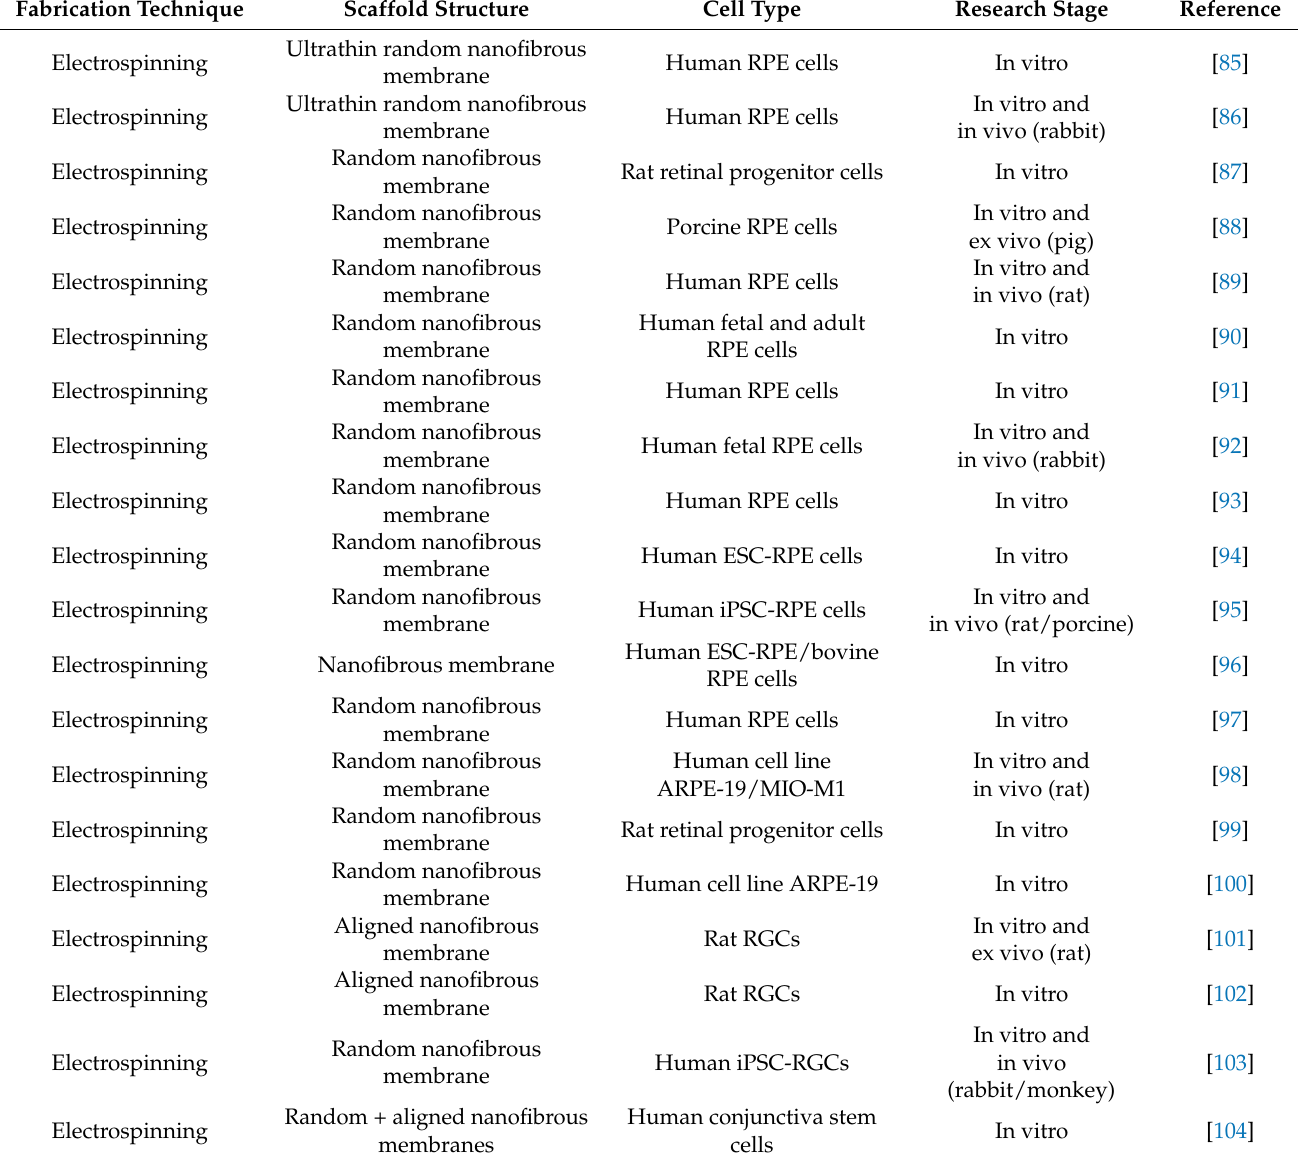
Table 2. A summary of retinal scaffolds fabricated by electrospinning. This table highlights the fabrication technique, the structure of the scaffold and the cell type used. RPE: retinal pigment epithelium; ESC: embryonic stem cells; iPSC: induced pluripotent stem cells; RGC: retinal ganglion